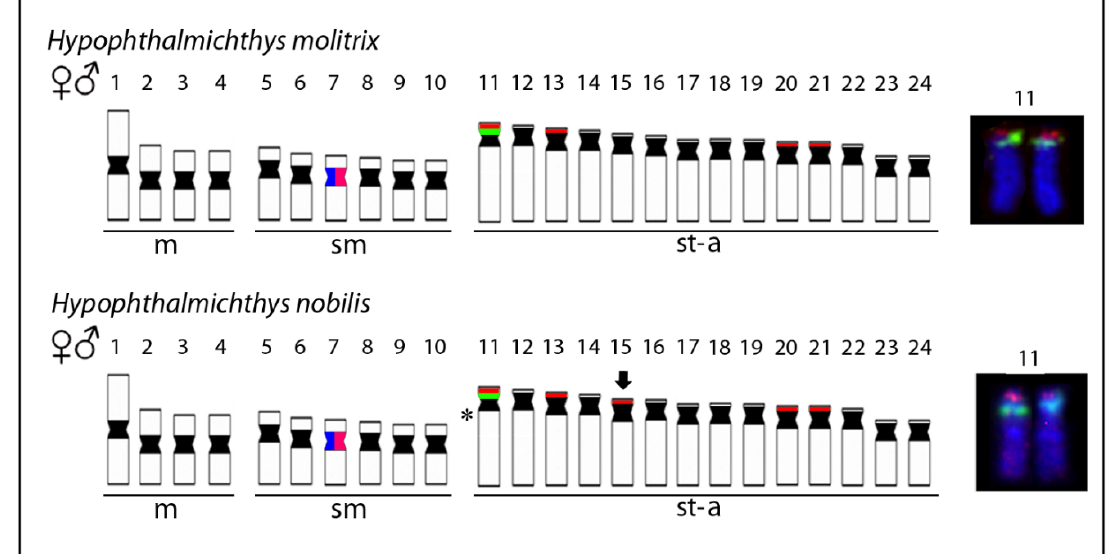
Figure 5. Representative idiograms of two Hypophthalmichthys species highlighting the distribution of analyzed multigene families. 18S (red) and 5S (green) rDNA sites and U1 (blue) and U2 (pink) snDNA sites on the chromosomes of H. molitrix and H. nobilis . Note the co-localization of snDNA sites on the chromosome pair 7 and the adjacent arrangement of 5S and 18S rDNA sites on the chromosome pair 11. Moreover, notice the additional 18S rDNA site on chromosome pair 15 in H. nobilis (marked by arrow) in comparison to the karyotype of H. molitrix . Finally, an asterisk denotes the location of the di ff erential interstitial C-band, which is present in H. nobilis but absent in H. molitrix . Insets with the chromosome pair 11 (right) display the chromosomes dissected from prometaphase plates after rDNA FISH, where the adjacent arrangement of both rDNA classes is clearly visible.